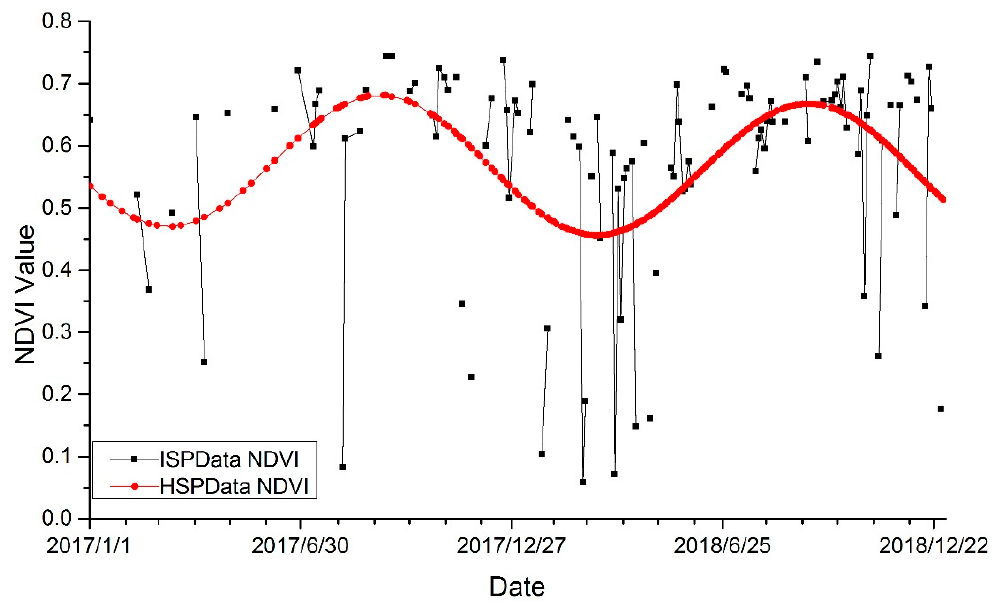
Figure 5. Time series Sentinel normalized difference vegetation index (NDVI) profile before (initial Sentinel phenological dataset, ISPData) and after (high-quality Sentinel phenological dataset, HSPData) the HANTS (harmonic analysis of time series) algorithm.